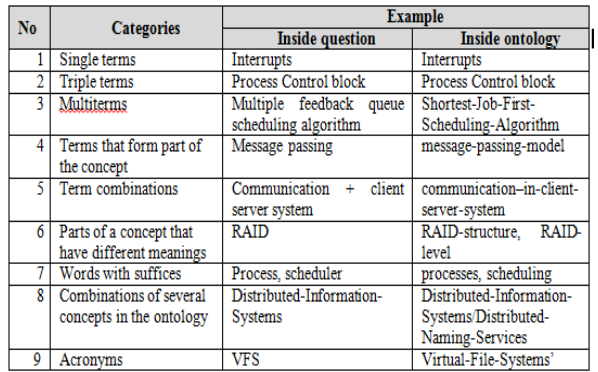
Table 2. Term pattern examples in M2 categories.